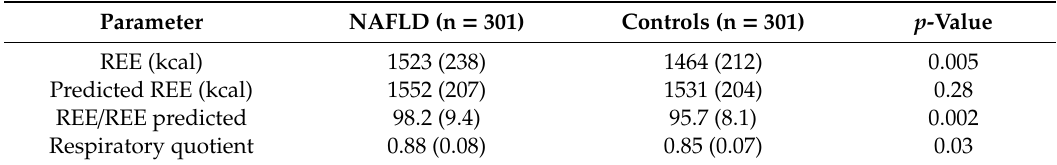
Table 3. Calorimetric parameters related to the presence or not of hepatic steatosis.